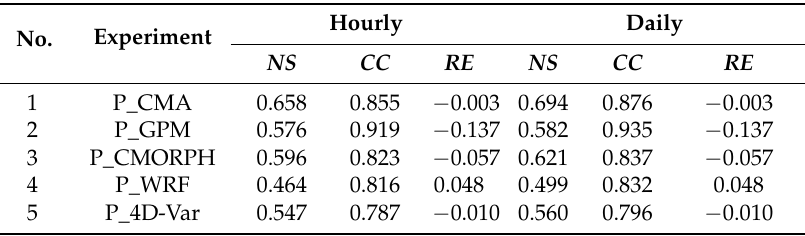
Table 8. Evaluation results of the hourly and daily outlet discharges simulated by the different rainfall-runoff experiments